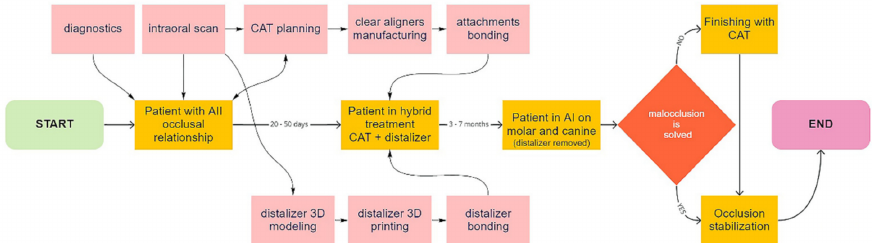
Figure 3. Scheme describing new digital workflow for orthodontists utilizing certified biocompatible dental resins for 3D printed personalized distalizers for hybrid treatment.